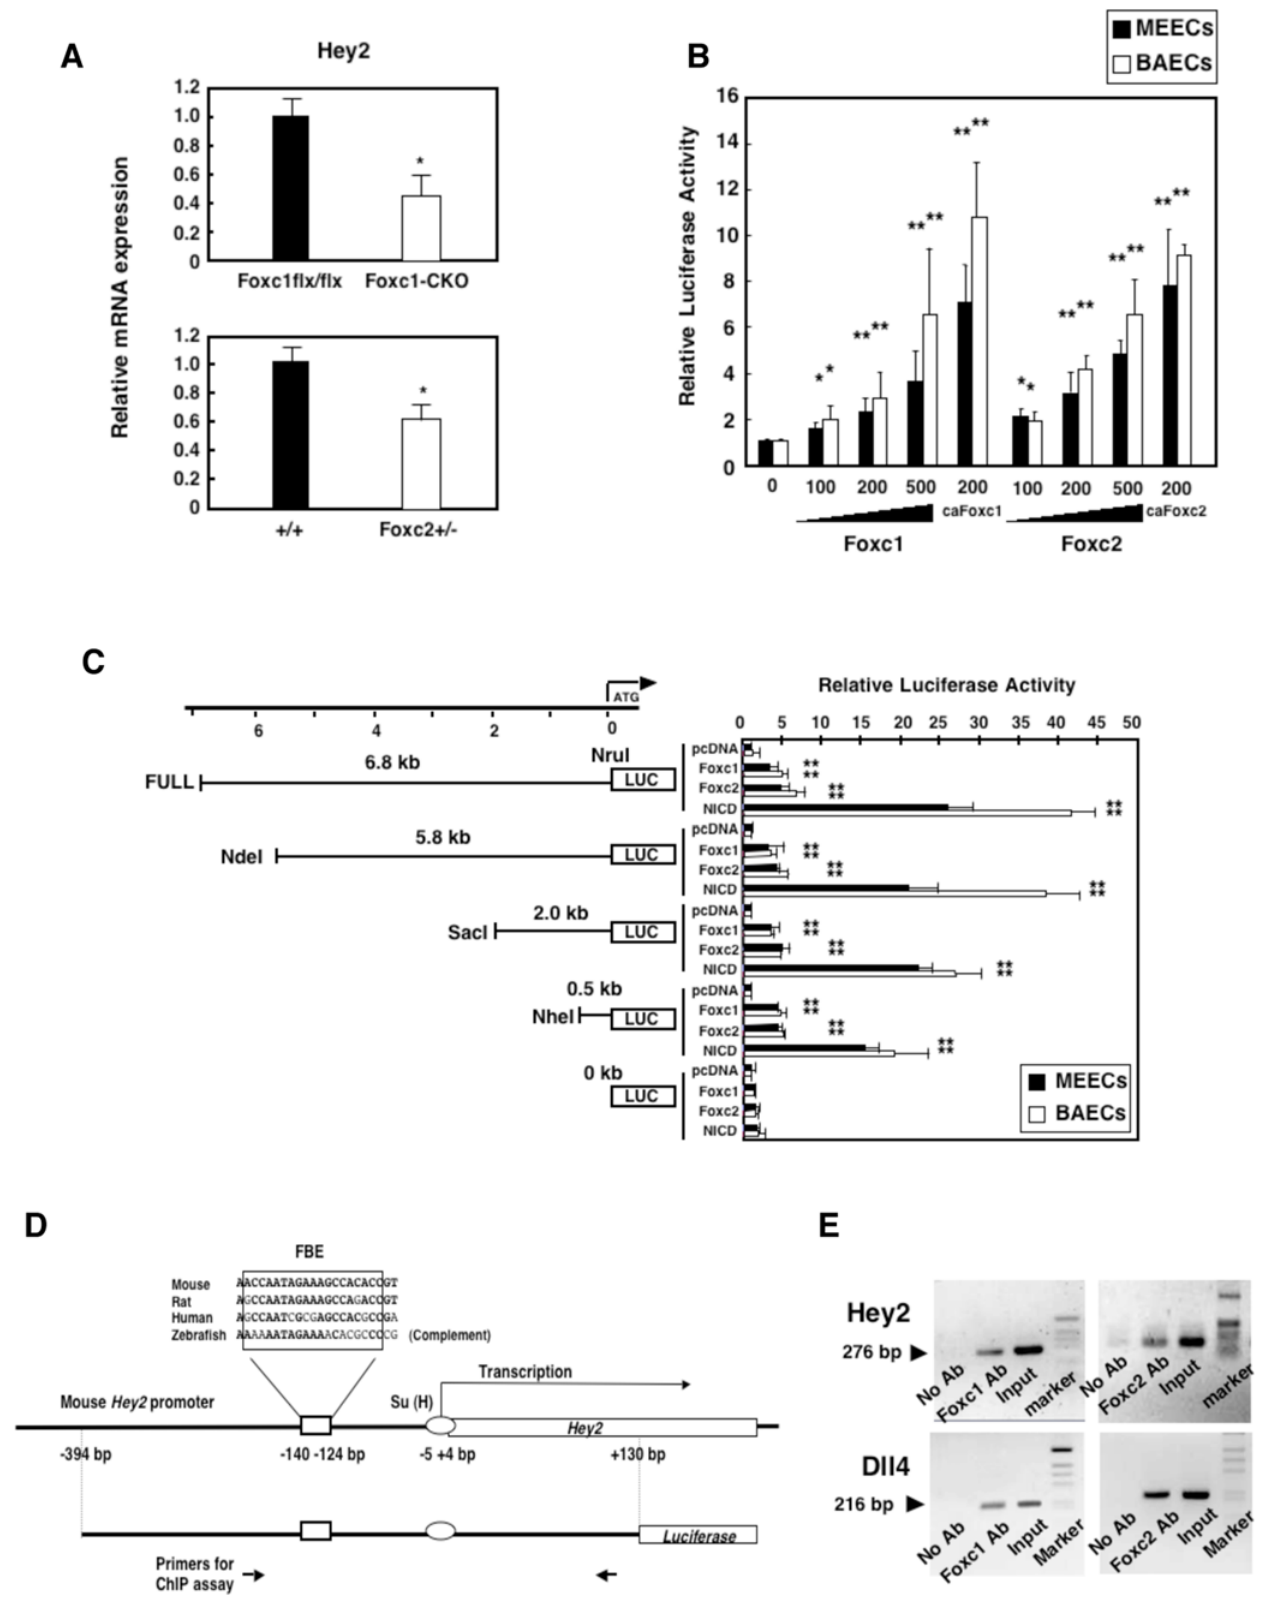
Figure 1. Foxc1 and Foxc2 directly regulate Hey2 expression. (A) Reduced expression of Hey2 in Foxc-mutant endothelial cells. Total RNA was prepared from PMVECs isolated from control (Foxc1flx/flx) and endothelial-specific Foxc1 conditional mutant (Foxc1-CKO) mice (upper panel) as well as wild-type and Foxc2 + / 2 mice (lower panel). Relative mRNA levels of Hey2 were measured by real-time RT-PCR. Values are mean + s.d. of